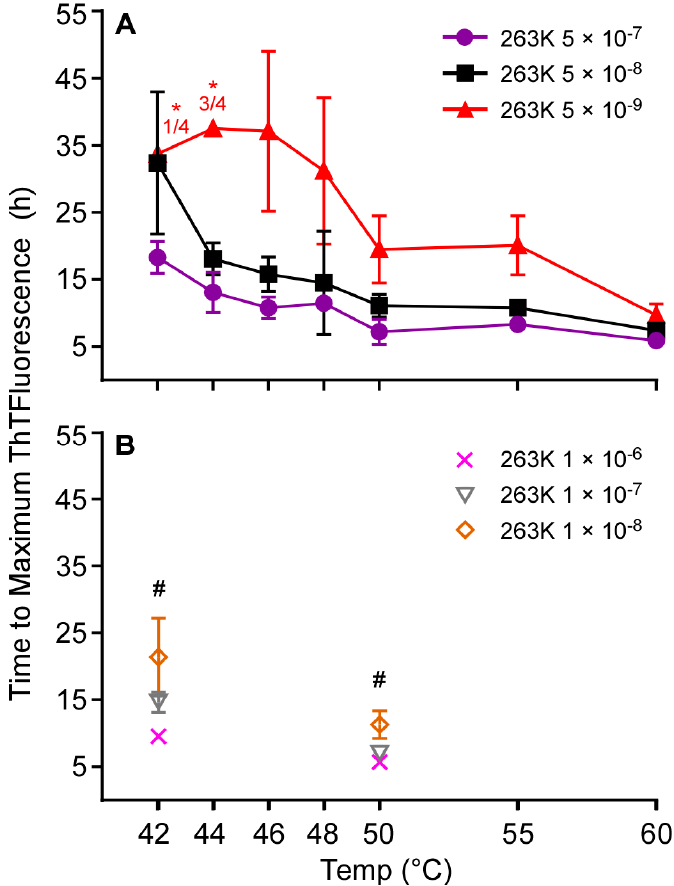
Figure 2. Effect of temperature elevation on RT-QuIC detection of hamster 263K brain homogenate derived seeding activity using Ha rPrP Sen 90–231. RT-QuIC reactions seeded with the designated hamster 263K positive brain tissue dilutions were incubated at temperatures of 42–60 °C ( x axis). The graphs (A, B) show the average time (hours, y -axis) to maximum ThT fluorescence (±SD) of quadruplicate reactions for each brain tissue dilution. * Fractions in red (A) indicate the number of ThT positive replicate wells (numerator) out of the set of four replicate wells (denominator). No SD was calculated for the reactions marked with an asterisk (*). (#) Differences were statistically significant (B) with p values < 0.002, 0.001 and 0.05 for the 1 × 10 − 6 (X), 1 × 10 − 7 ( ) and 1 × 10 − 8 ( ◊ ) 263K brain tissue dilutions, respectively.